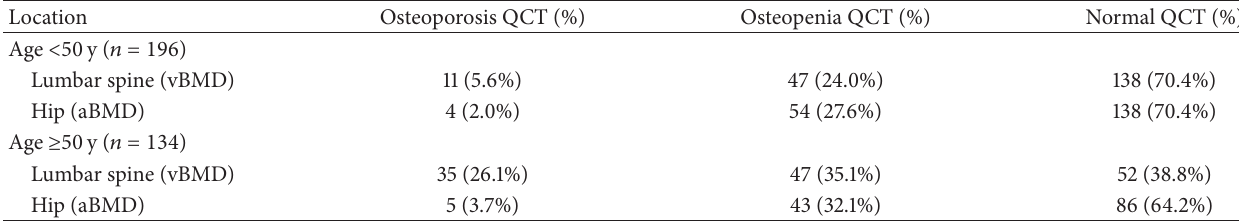
Table 1: The diagnostic rates classification with vBMD versus aBMD in males.